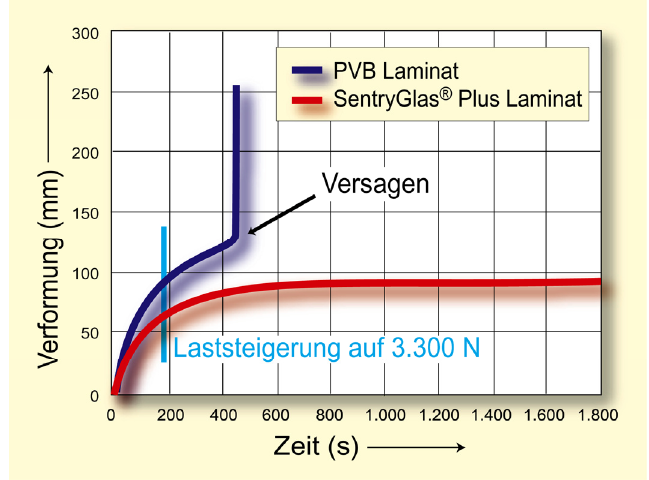
Figure 6: Comparison of creep behavior in laminates with PVB and SentryGlas® following glass